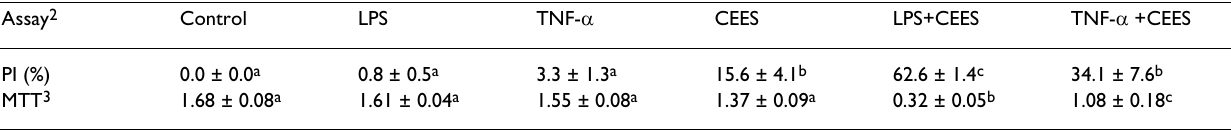
Table 2: TNF- α Enhances the Cytotoxicity of CEES to RAW264.7 Macrophages (24 hours) 1 Assay